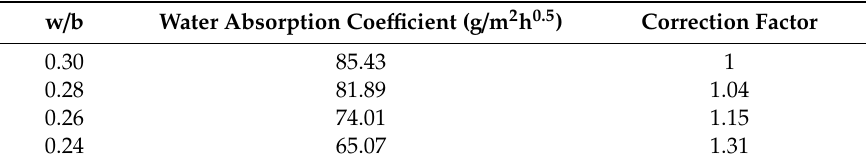
Figure 11. Water absorption coefficient of different w/b ratio concretes. Table 8. Calibration procedure for the water absorption